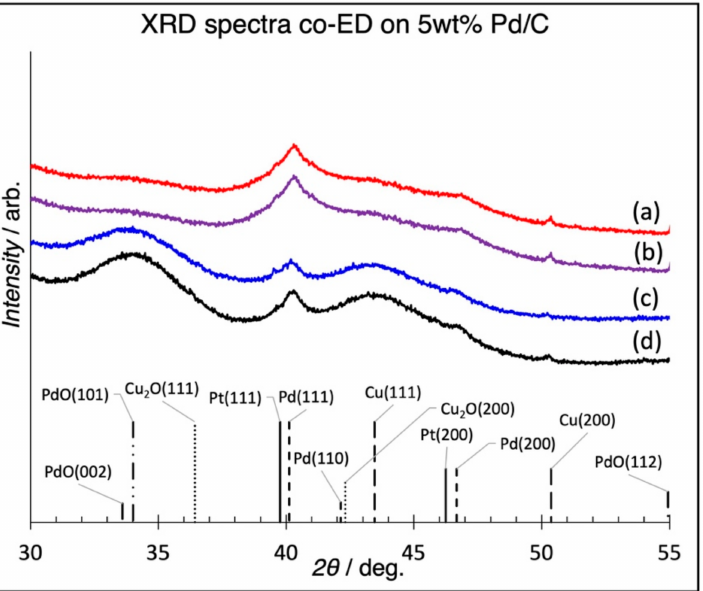
Figure 3. Powder XRD patterns of base Cu 5.8 Pt ( a ), Cu 3.3 Pt ( b ), Cu 0.18 Pt ( c ), and 5 wt % Pd/C catalyst ( d ). The absence of Cu 2 O peaks supports the mixed Pt–Cu shell assignment. The unresolved, broad and diffuse peaks between Pt(111) and Cu(111) are consistent with mixed Cu–Pt alloy shell. The absence of Cu 2 O, Cu 0 , or Pt 0 peaks indicates no formation of these species and that phase segregation had not